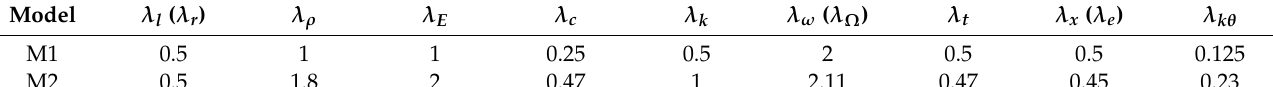
Table 2. The scaling factors of the models M1 and M2.